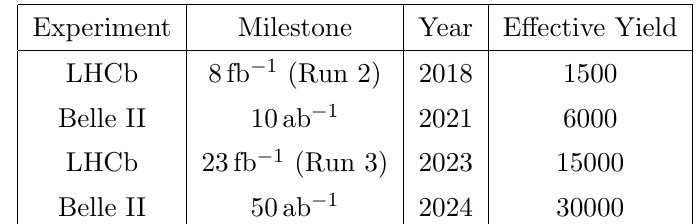
Table 3 . Expected combined e(cid:11)ective tagged yields of B 0 ! (cid:26) 0 (cid:26) 0 and B 0 ! a (cid:6)